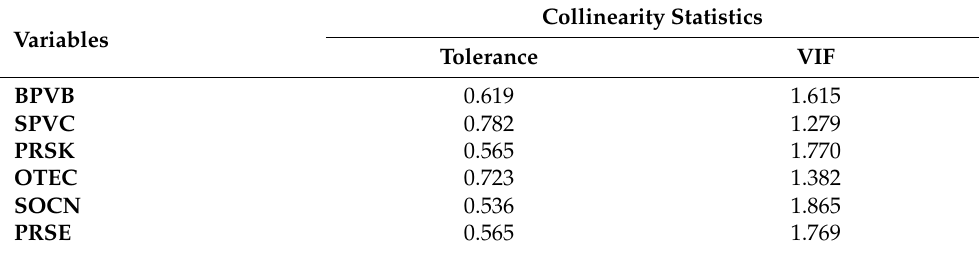
Table 9. Collinearity diagnostic test.